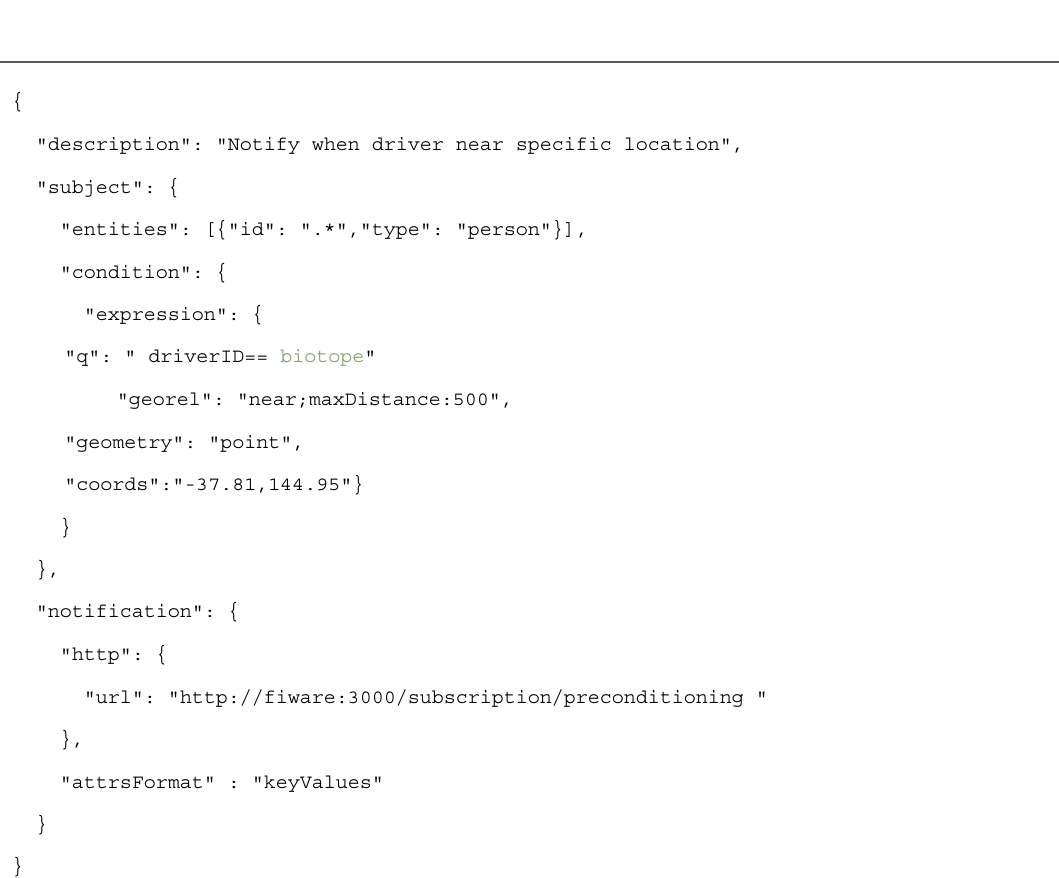
Scheme 18. NGSI Scheme 18. NGSI subscription.